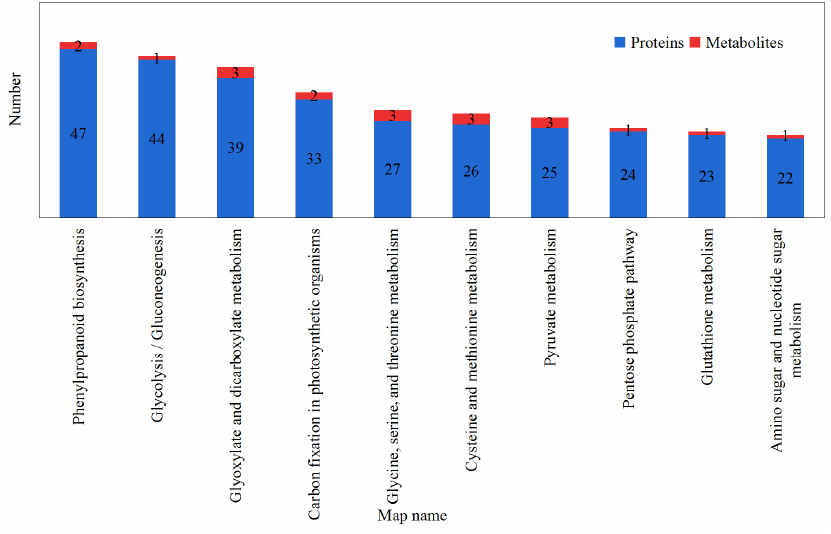
Figure 6. Pathways through which differentially expressed proteins and metabolites participate. The blue color represents differentially expressed proteins, while the red color represents differentially enriched metabolites.